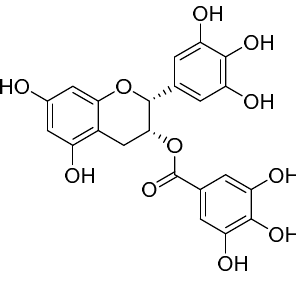
Figure 3. Chemical structure of epigallocatechin-3-gallate (EGCG).